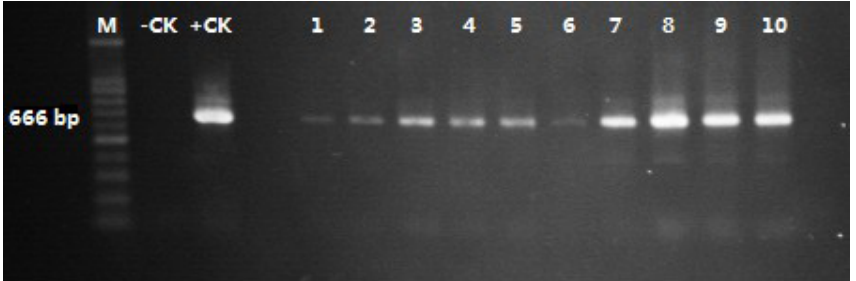
Figure 3. Identification of AhDREB 1 in the transgenic trees by PCR amplification. −CK, DNA from non-transgenic poplars; +CK, plasmids containing AhDREB 1; M, DNA marker (100-bp DNA ladder); 1–10, DNA from transgenic